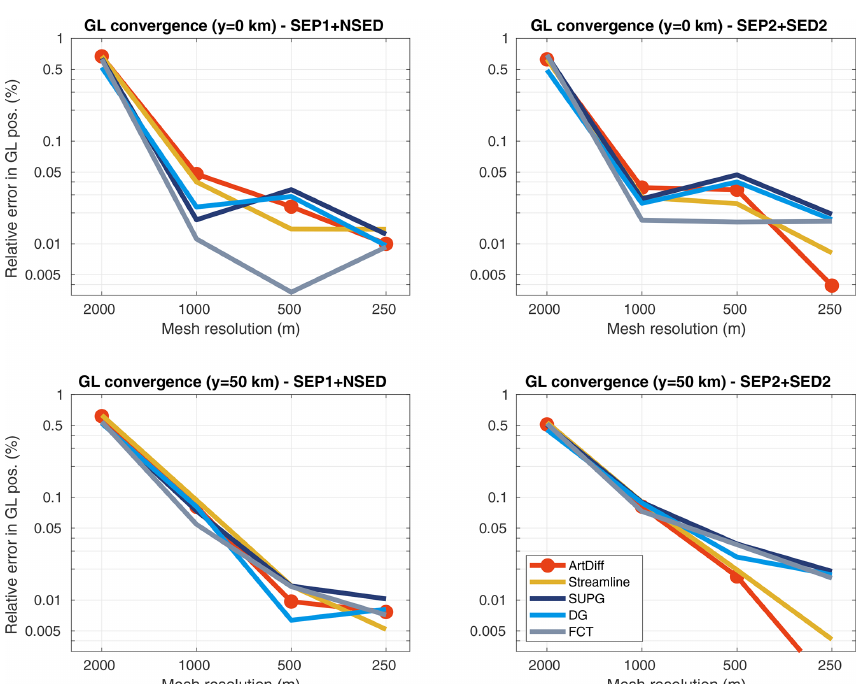
Figure 15. Basal friction perturbation experiment: convergence of grounding line positions (relative errors) at the end of the experiment ( t = 100 years) for y = 0 (top panels) and y = 50km (bottom panels) and for different stabilization schemes (see legend). Two sets of sub- element parameterizations are employed: SEP1 + NSED (left panels) and SEP2 + SED2 (right panels). The relative errors are computed using Eq. (45) and replacing (cid:49) VAF by the grounding line